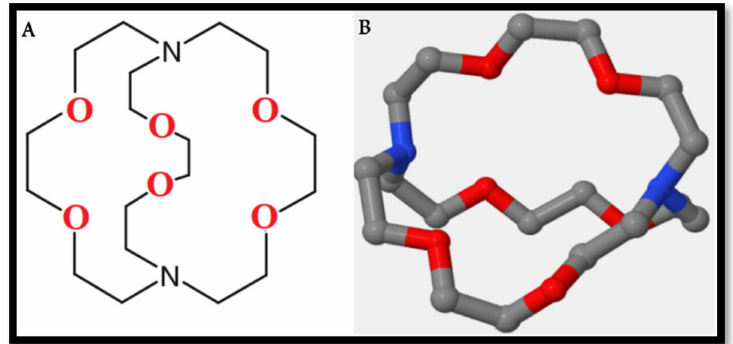
Figure 1. ( A ) Two-dimensional (2D) structure of K2.2.2, and ( B ) three-dimensional (3D) structure of